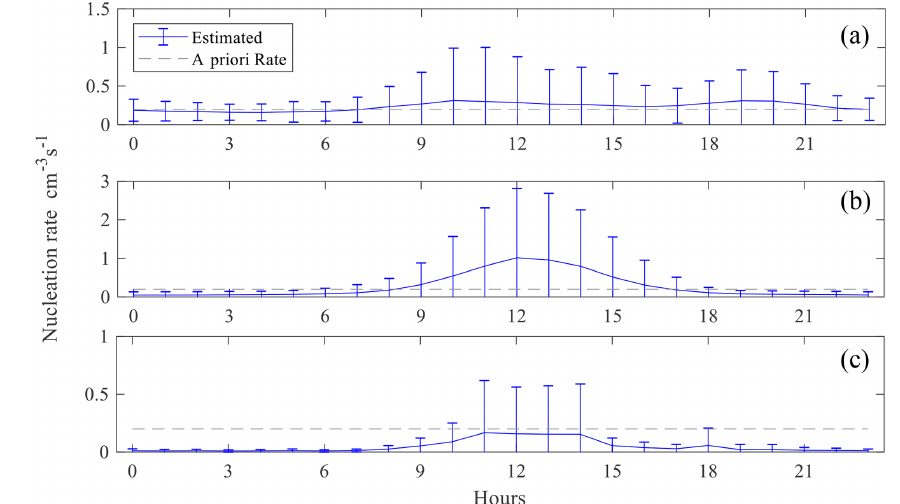
Figure 10. Estimated diurnal nucleation rate during stagnant events for each measurement site: (a) San Pietro Capofiume, (b) Melpitz, (c) Hyytiälä. Blue solid and grey dashed lines show the estimated rate and a priori rate, respectively; the error bars show the standard deviation across all